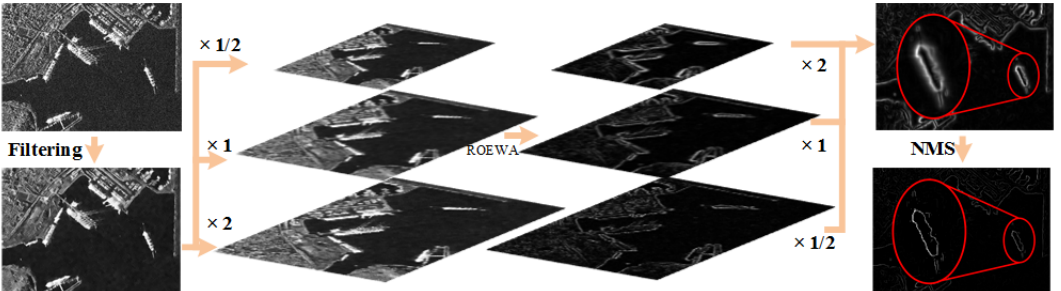
Figure 3. The scheme of edge